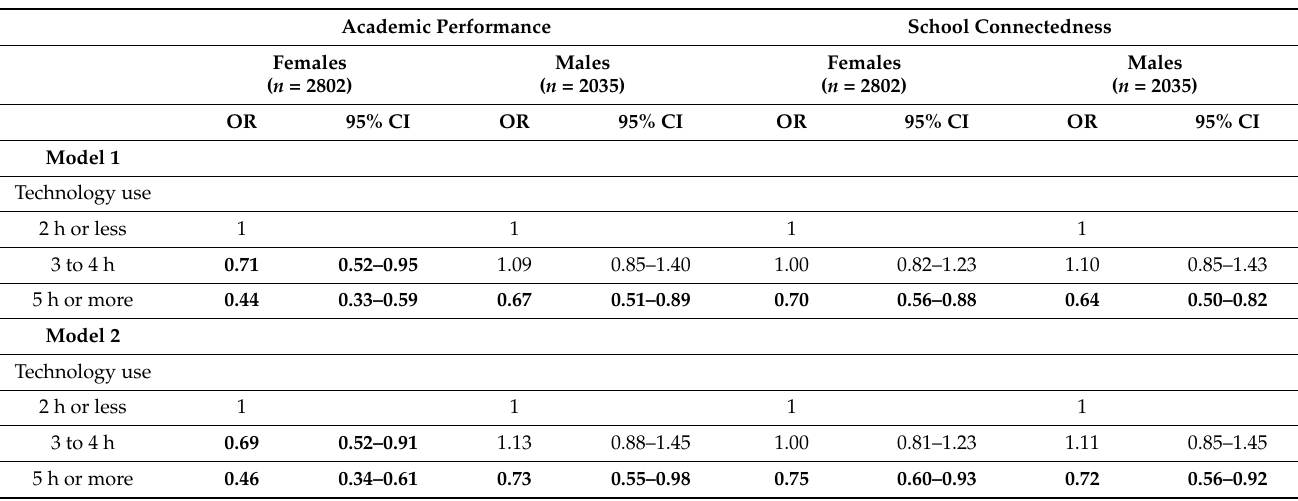
Figure 1. Symptoms of problem technology use among female (Panel A ) and male (Panel B ) adolescents. Table 2. Associations of time spent using technology with academic performance and school connect- edness among adolescent females and